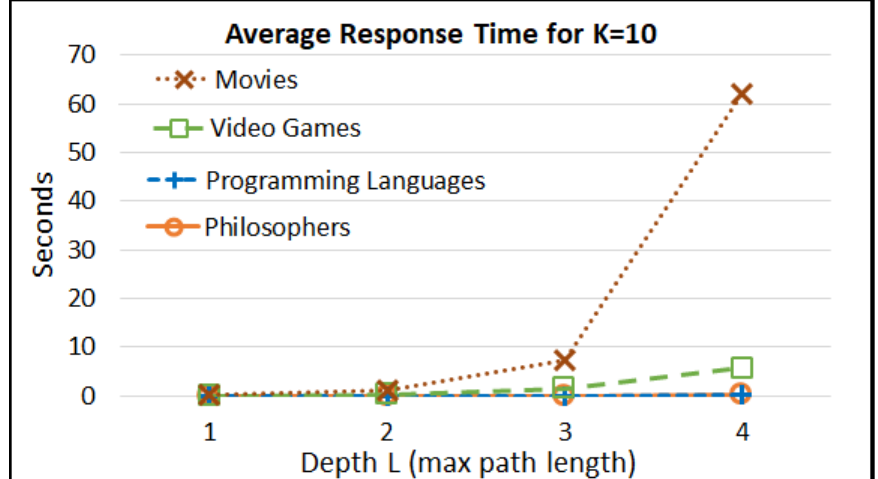
Figure 11. Average time for creating the similarity graph for K = 10.